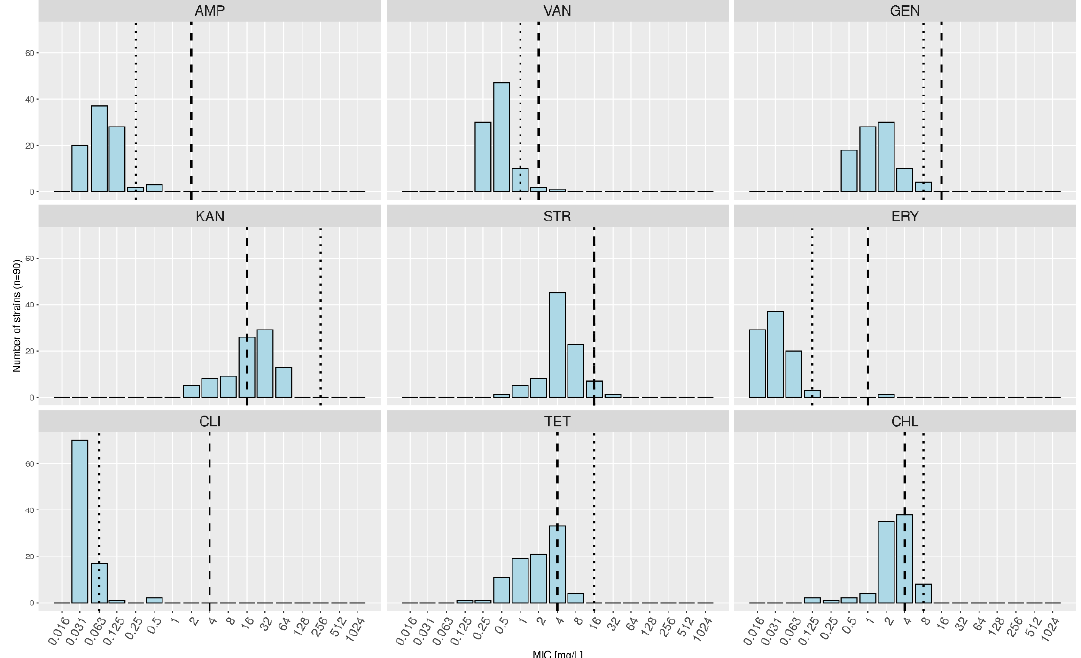
Figure 3. Combined minimal inhibitory concentration (MIC) distributions for Lactobacillus delbrueckii subsp. lactis and L. delbrueckii subsp. bulgaricus . The dashed lines indicate the current microbiological cutoffs (MCs) as defined by the European Food Safety Authority, and the dotted lines represent the calculated MCs based on the MICs measured in this study.